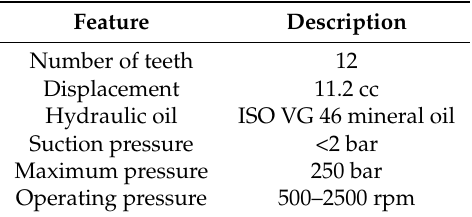
Figure 14. Scaled view of two of the TSVs corresponding to the drive gear in Figure 13 showing the radial leakage connections ( Q r ), lateral leakage connection ( Q l ), backflow groove connection ( Q b ) and drain leakage connection ( Q d ). Table 1. Main specifications for the EGM